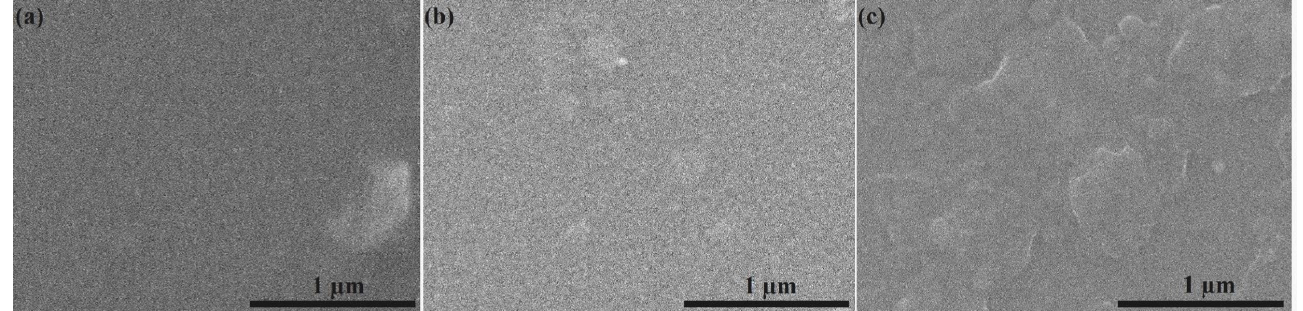
Figure 3. SEM micrographs obtained for HApCh ( a ), 8MgHApCh ( b ) and 30MgHApCh ( c ) compos-